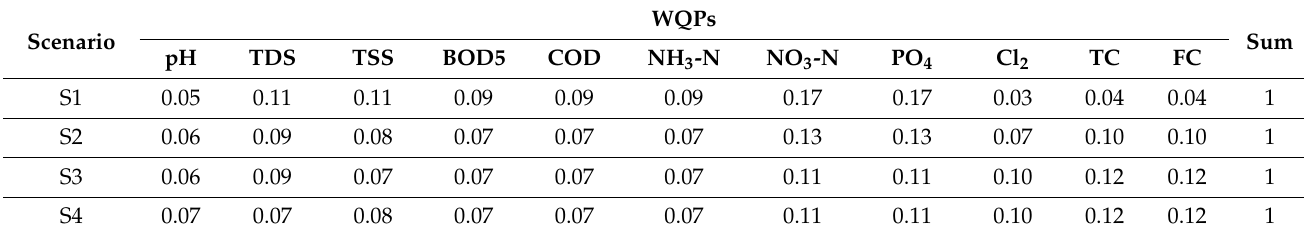
Table 8. Importance weights estimated using entropy method for all the